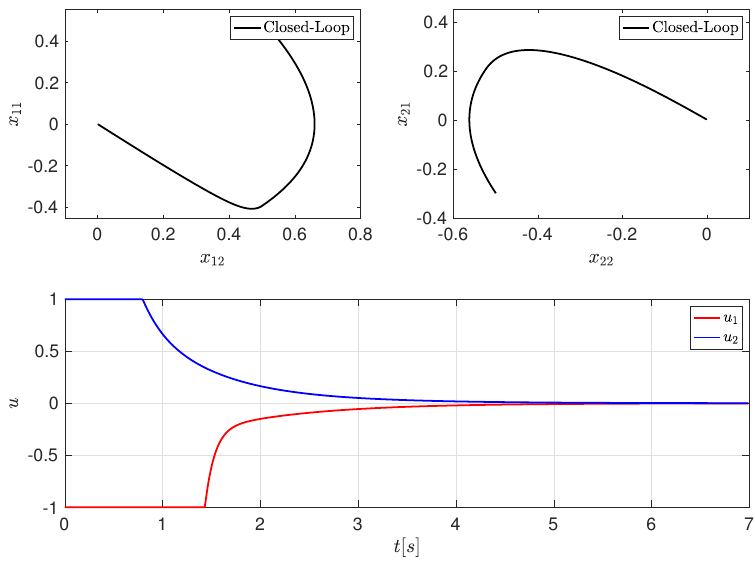
Figure 4. Closed-loop local phase-plane and inputs of the Duffing